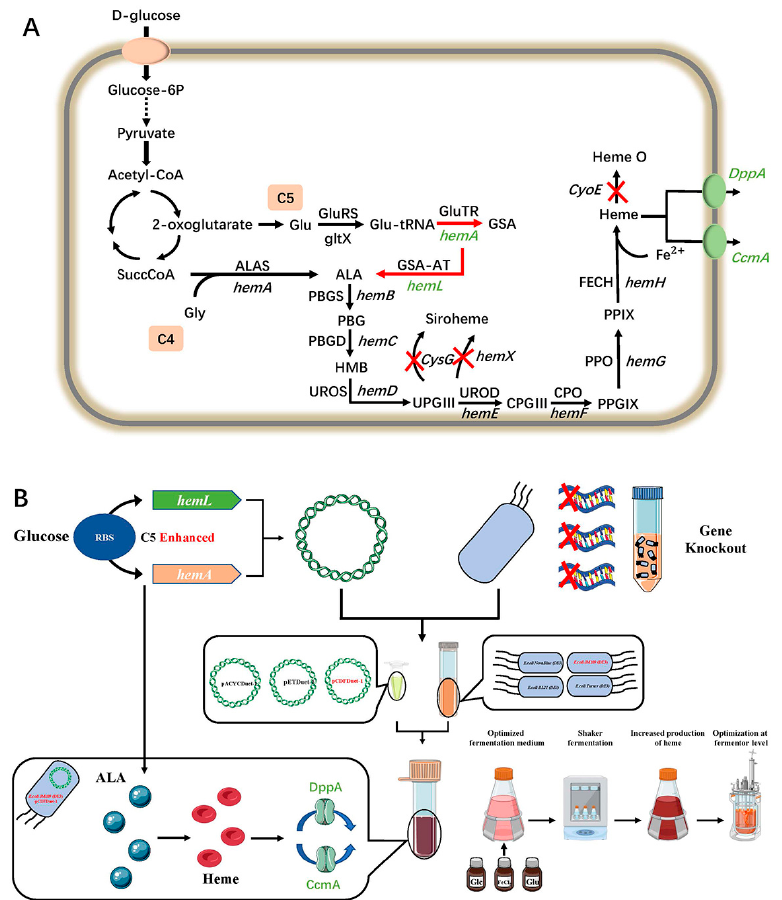
Figure 1. ( A ) A schematic overview describing the target pathway and overall metabolic strategies for ALA and Heme production in E. coli . In this study, glucose was the only major source of energy for cell growth and porphyrin production. The green letter represents the gene overexpression in E. coli . The red X-shape denote the gene knockout. The solid-line arrow and dashed-line arrow indicate the general metabolic pathway and abbreviated pathway, respectively. The red arrow denotes en- hanced metabolic flux by the combinatorial overexpression of hemA and hemL . Green ovals indicate enhanced extracellular transport pathways for heme by insertion of the target gene. ( B ) Strategies for modifying the biosynthesis of heme in E. coli . 2. Results and Discussion 2.1. Improving HemA and HemL Expression in E. coli Host Strains To screen a proper host for heme production in E. coli strains, the expression of genes hemA and hemL coding for glutamyl-tRNA reductase (GluTR) and glutamyl-1-hemal transaminase (GSA-AT) in the C5 pathway of ALA production were first enhanced in E.